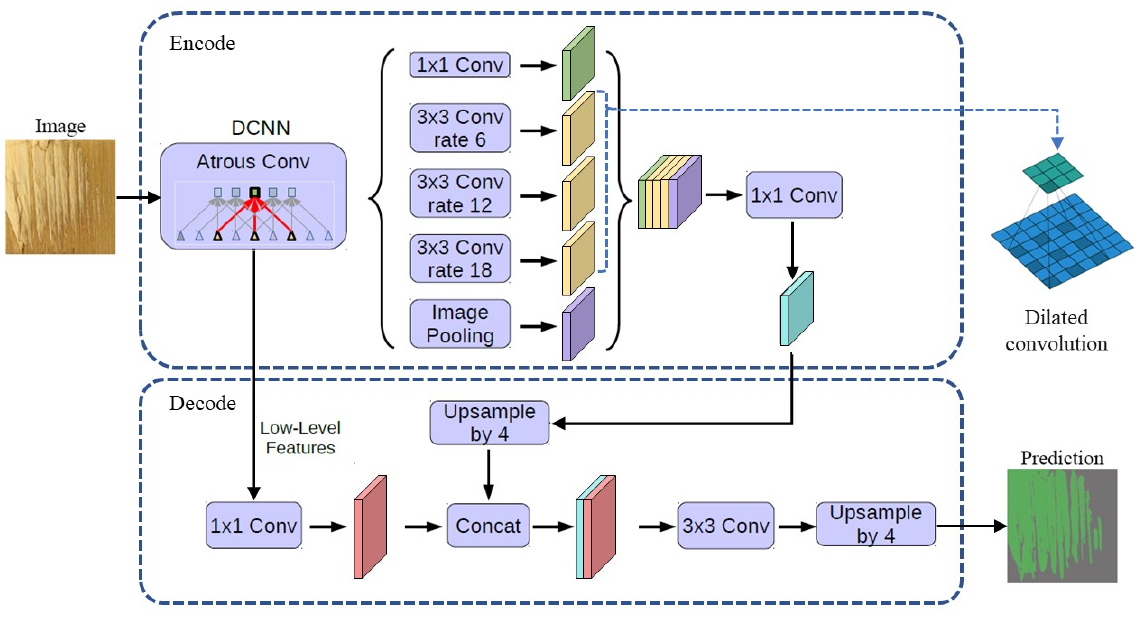
Figure 8. DeepLab_v3+ model.